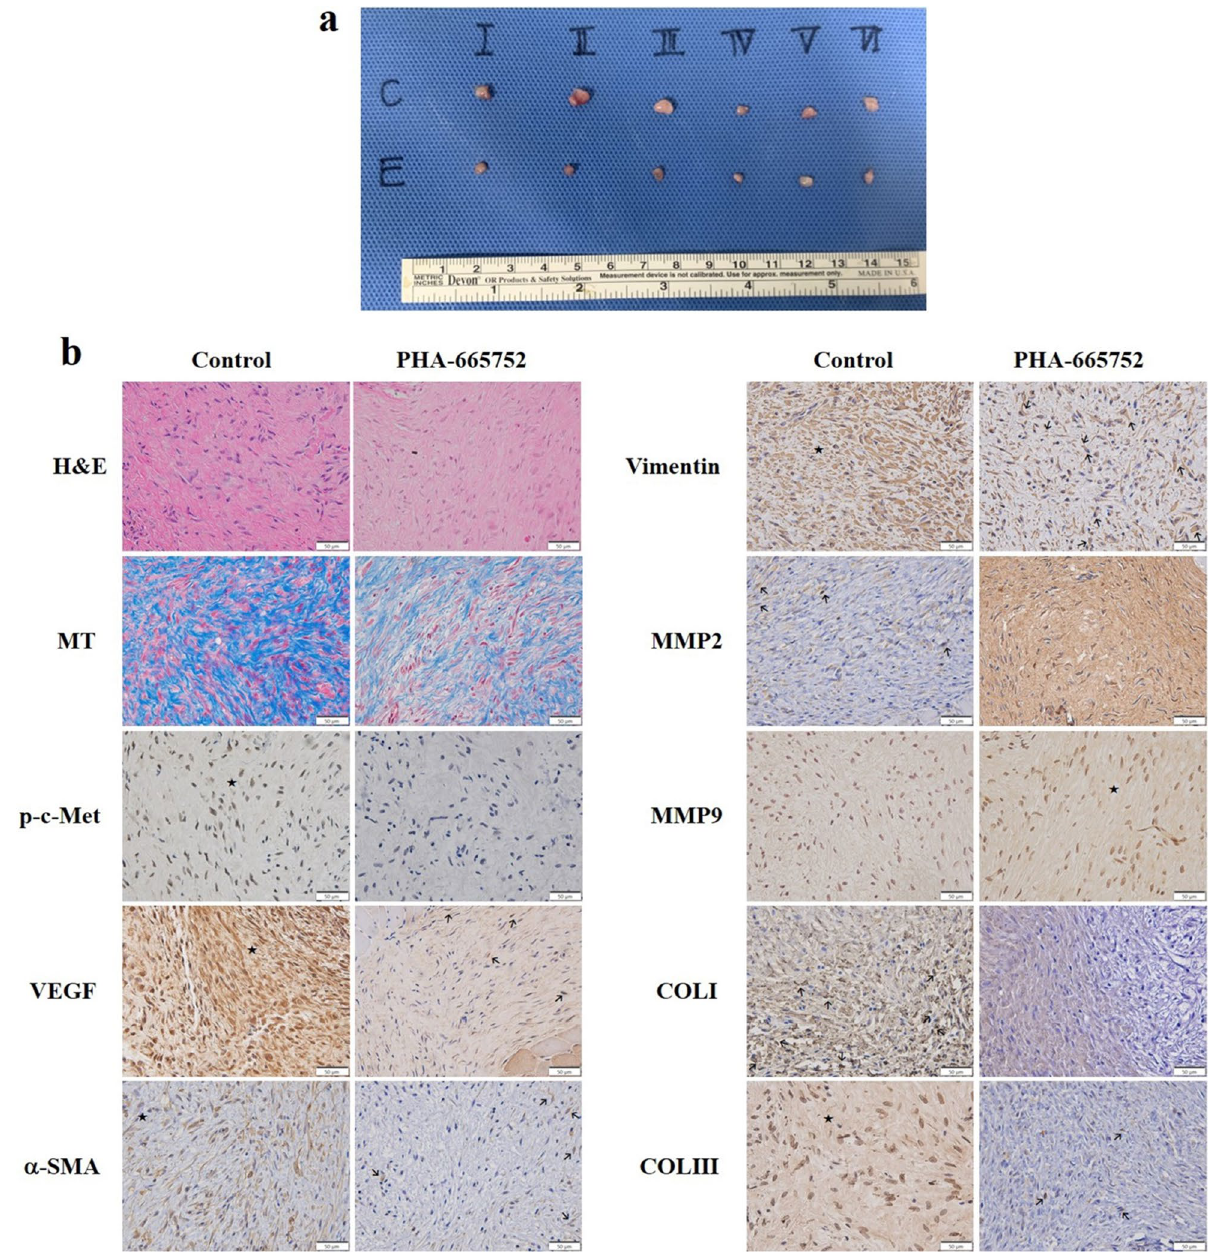
Figure 5. Histological and immunohistochemical images of the nodules formed by human keloid fibroblasts in SCID mice 7 days after PHA-665752 treatment. ( a ) Nodules were harvested from mice treated with DMSO or PHA-665752. ( b ) Representative H&E staining, MT staining, and immunohistochemistry for the expression of p-c-Met, VEGF, α-SMA, vimentin, MMP2, MMP9, COL I, and COL III in the nodules. The arrows (individual cells) and star (most cells) represent positive (brown) expression. (Original magnification: 400 × , scale bar = 50 keloid fibroblast migration. Since fibroblast migration is known to be mediated by TGF-β activation, our findings are consistent with a previous study that suggested PHA-665752 has an inhibitory effect on TGF-β signaling 17 . After we determined the inhibitory effects of PHA-665752 on fibroblast survival, proliferation, and migration, we examined its effects on the expression of proteins that are involved in the formation of keloid scars. TIMP2 is an endogenous inhibitor of MMPs. High levels of TIMP2 lead to accumulation of the extracellular matrix (ECM), whereas low levels of TIMP lead to matrix proteolysis We found higher levels of MMPs and a lower TIMP2-to-β-actin ratio in cells treated with PHA-665752 than those in control cells. Although MMPs can be elevated during the wound-healing process 18 , concurrent MMP elevation and TIMP suppression suggest that PHA-665752 enhances MMP expression, resulting in less ECM accumulation. Consistent with this interpreta- tion, the c-Met inhibitor also suppressed collagen synthesis.